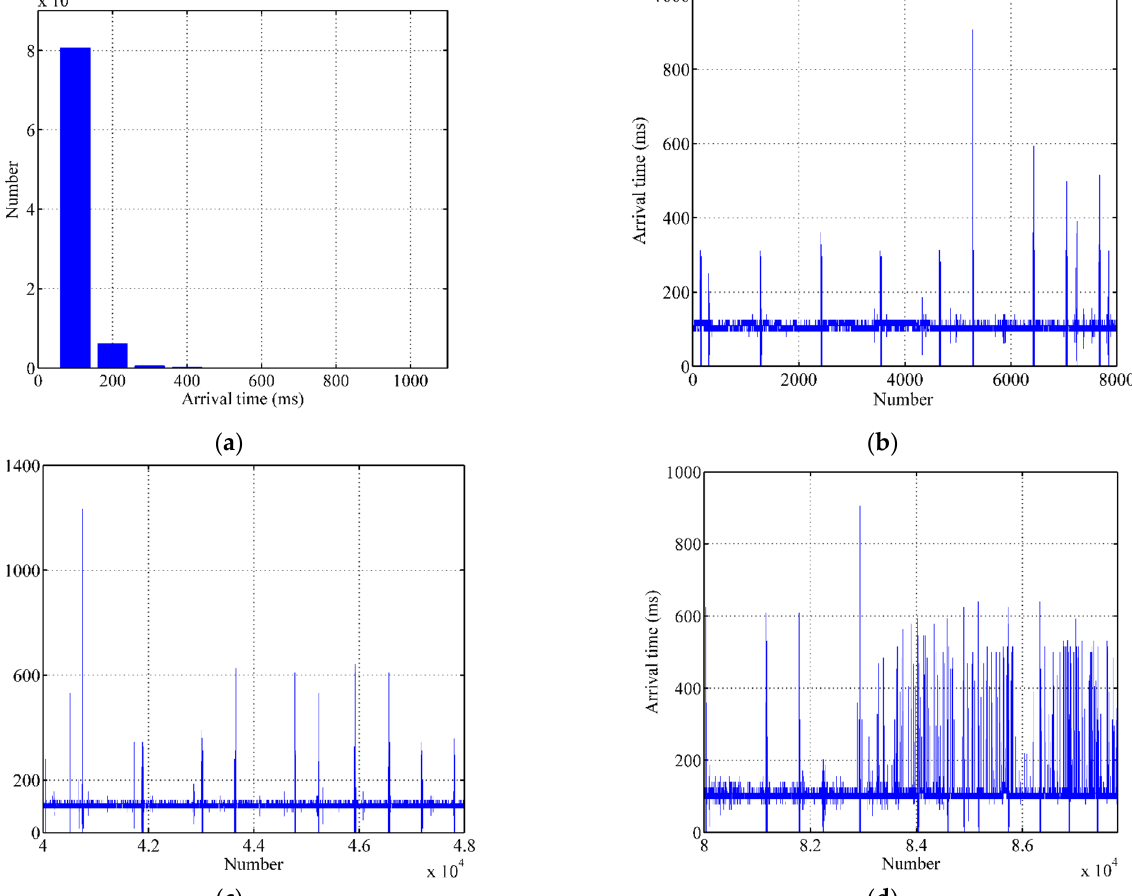
Figure 4. Analysis of actual data. ( a ) Distribution of arrival time, ( b )Early stage of arrival time, ( c ) Middle stage of arrival time, ( d ) Late stage of arrival time.